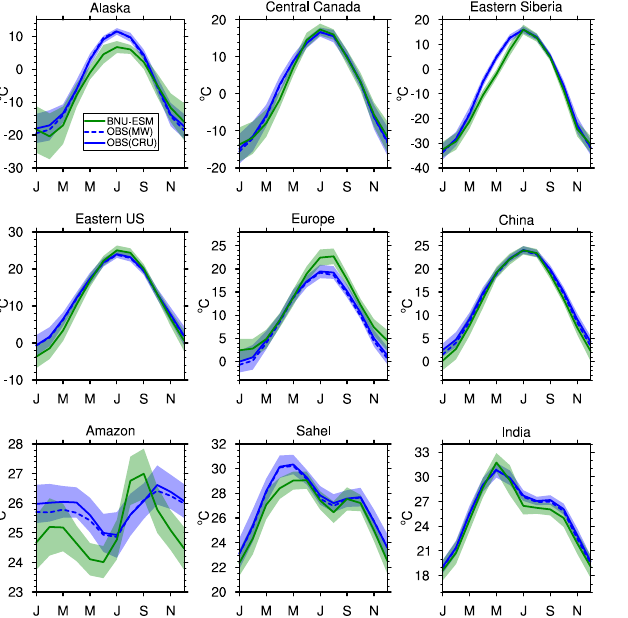
Figure 7. As for Fig. 6, but for precipitation for the period 1979– 2005. Color shading indicates interannual variability (standard de- viation). CMAP comes from the Climate Prediction Center (CPC) Merged Analysis of Precipitation 1979–2009 “standard” (no reanal- ysis data) monthly time series at 2.5 ◦ × 2.5 ◦ (Xie and Arkin, 1997). MW is version 2.01, 0.5 ◦ × 0.5 ◦ monthly time series from Matsuura and Willmott (2009b) for the years